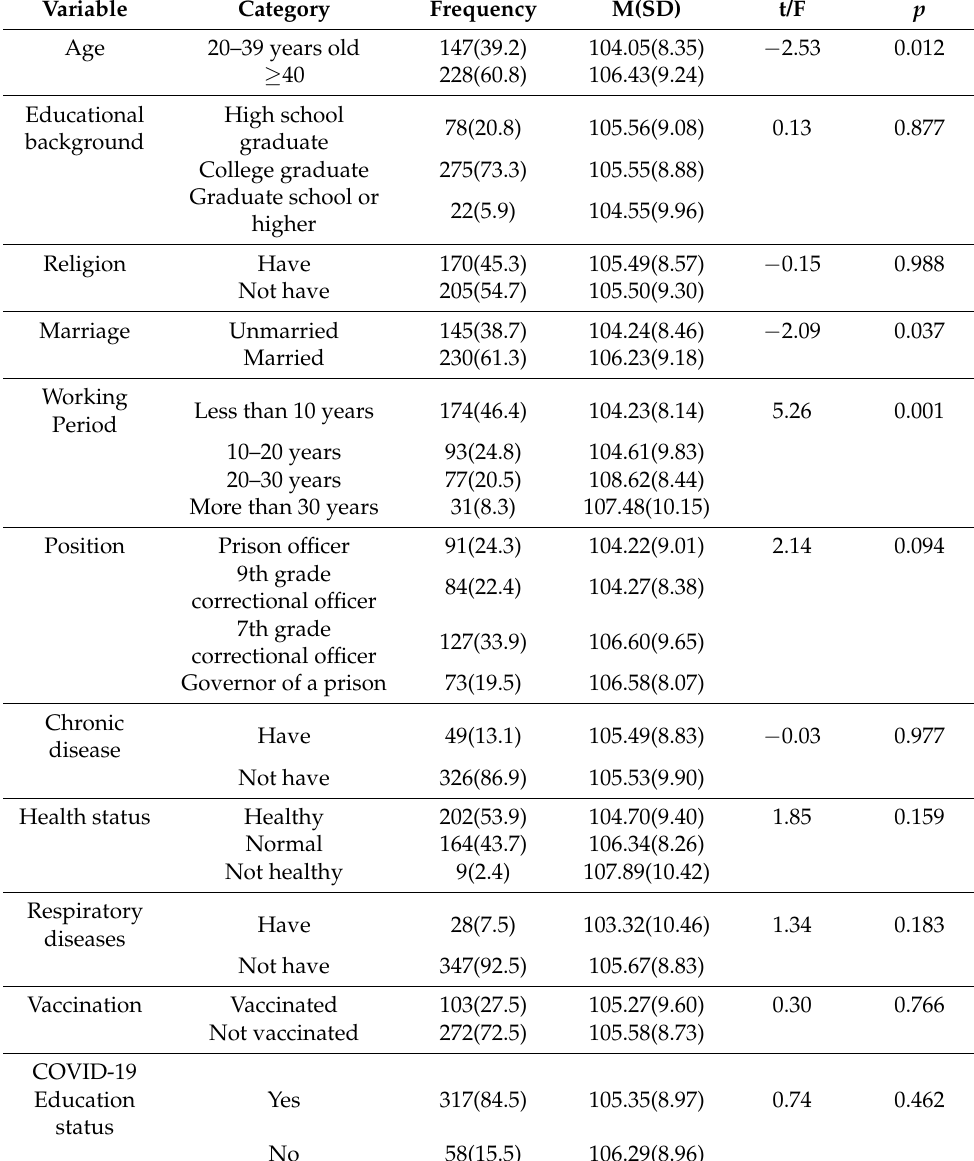
Table 1. Distribution by general characteristics of